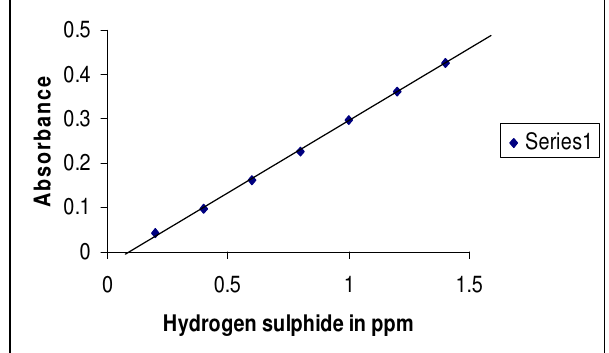
Figure 1. Calibration graph for the determination of Hydrogen sulphide under optimized experimental